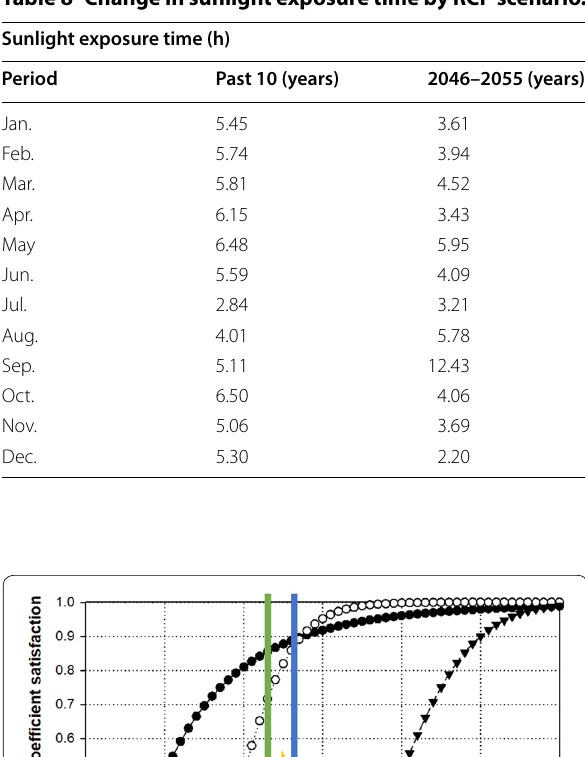
Table 8 Change in sunlight exposure time by RCP scenario.